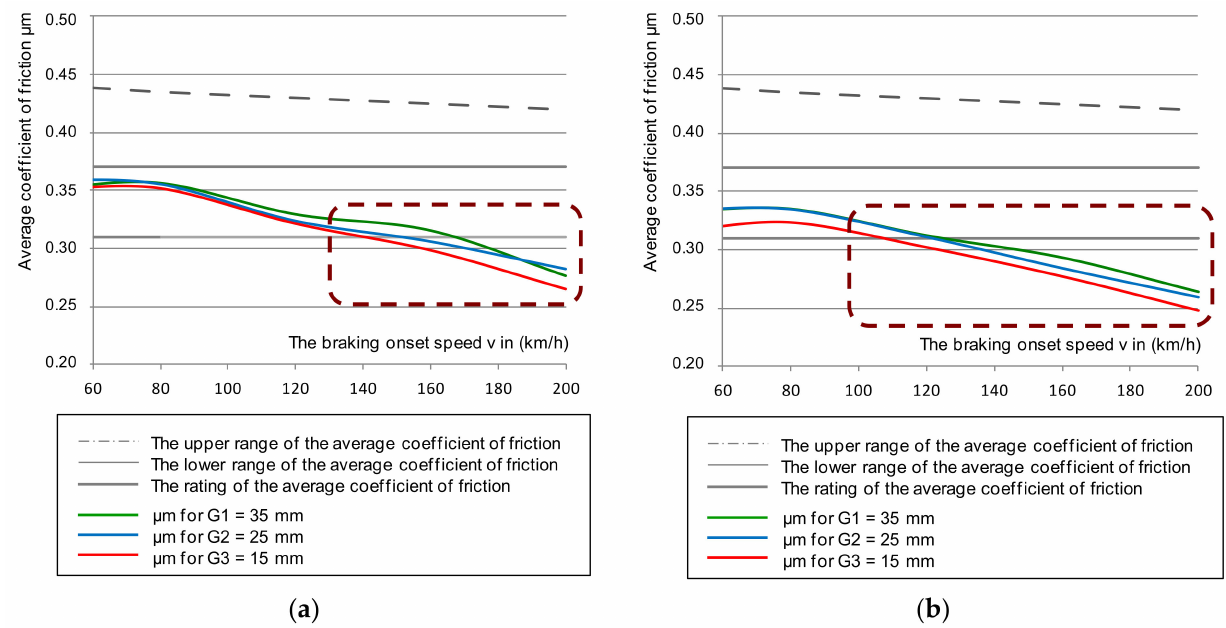
Figure 5. Characteristics of the average friction coefficient µ m on the braking start speed with a pressure of 44 kN and mass per disc of 7.5 t: ( a ) for a new disc, ( b ) for a worn